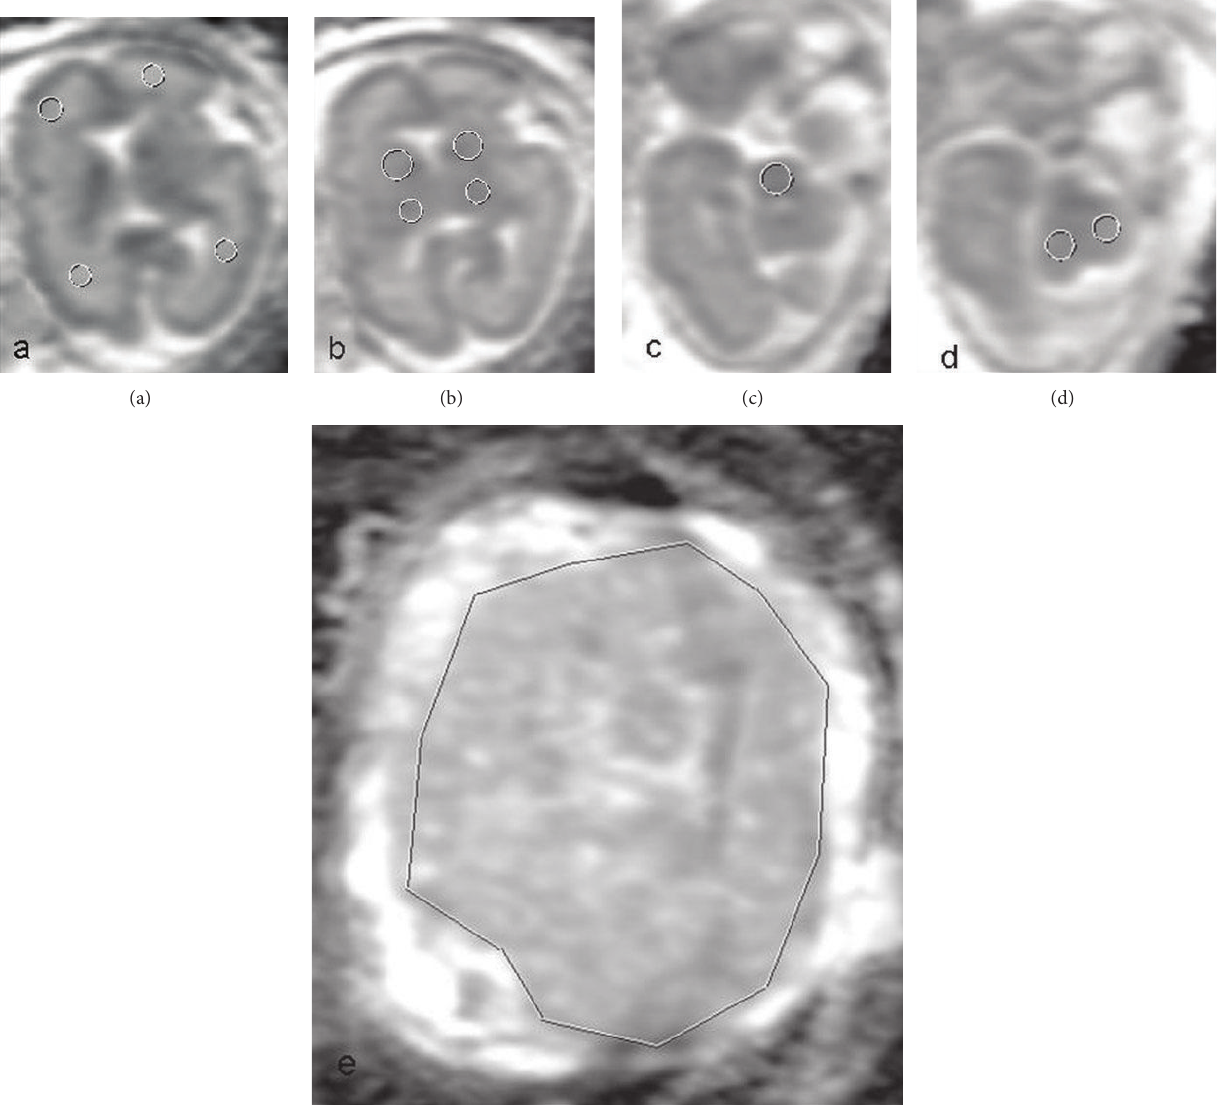
Figure 2: Examples of ADC calculations. ROI circles on white matter (a); thalami, lentiform nuclei (b); pons (c); cerebellum (d); and freehand ROI draw on placenta (e) are demonstrated.